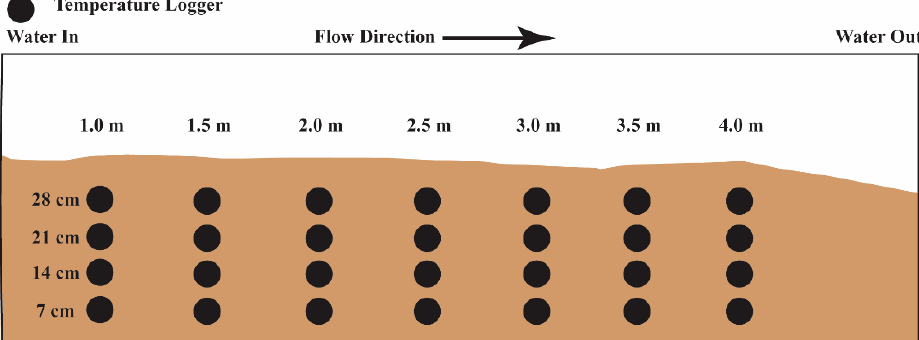
Figure 1. Conceptual model of hydraulic channel. The black circles represent the location of the temperature loggers. Loggers were placed uniformly within the substrate, vertically every 7 cm from the bottom of the flume, with a horizontal spacing of 0.5 m.